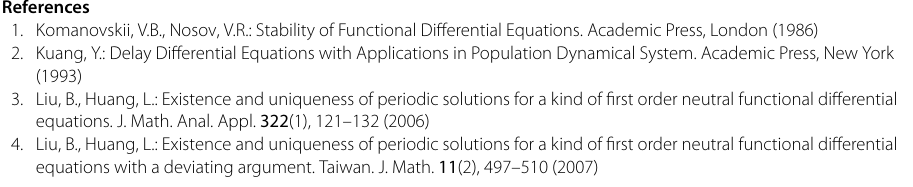
that the pseudo-almost periodic functions contain almost periodic functions, thus, the derived results are still novel if we reduce all time-varying delays and coefficients of (1.2) to periodic functions or almost periodic